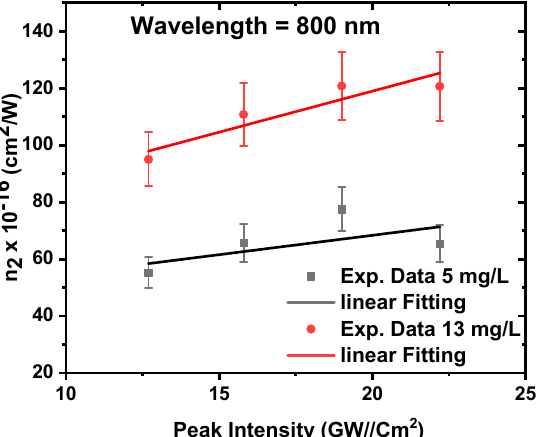
Figure 11. The CA Z–scan transmission of ZnONPs colloids prepared at different concentrations of 5 and 13 mg/L, irradiated by 800 nm, and at different incident peak intensities of ( a ) 12.7, ( b ) 15.8, ( c ) 19, and ( d ) 22.2 GW/cm 2 . The dots indicate the experimental results, and the solid lines indicate the theoretical fitting.